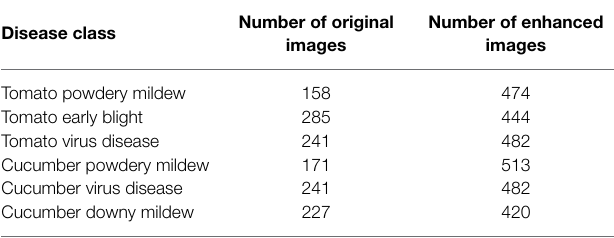
TABLE 3 | The specific number of images in the dataset. Disease